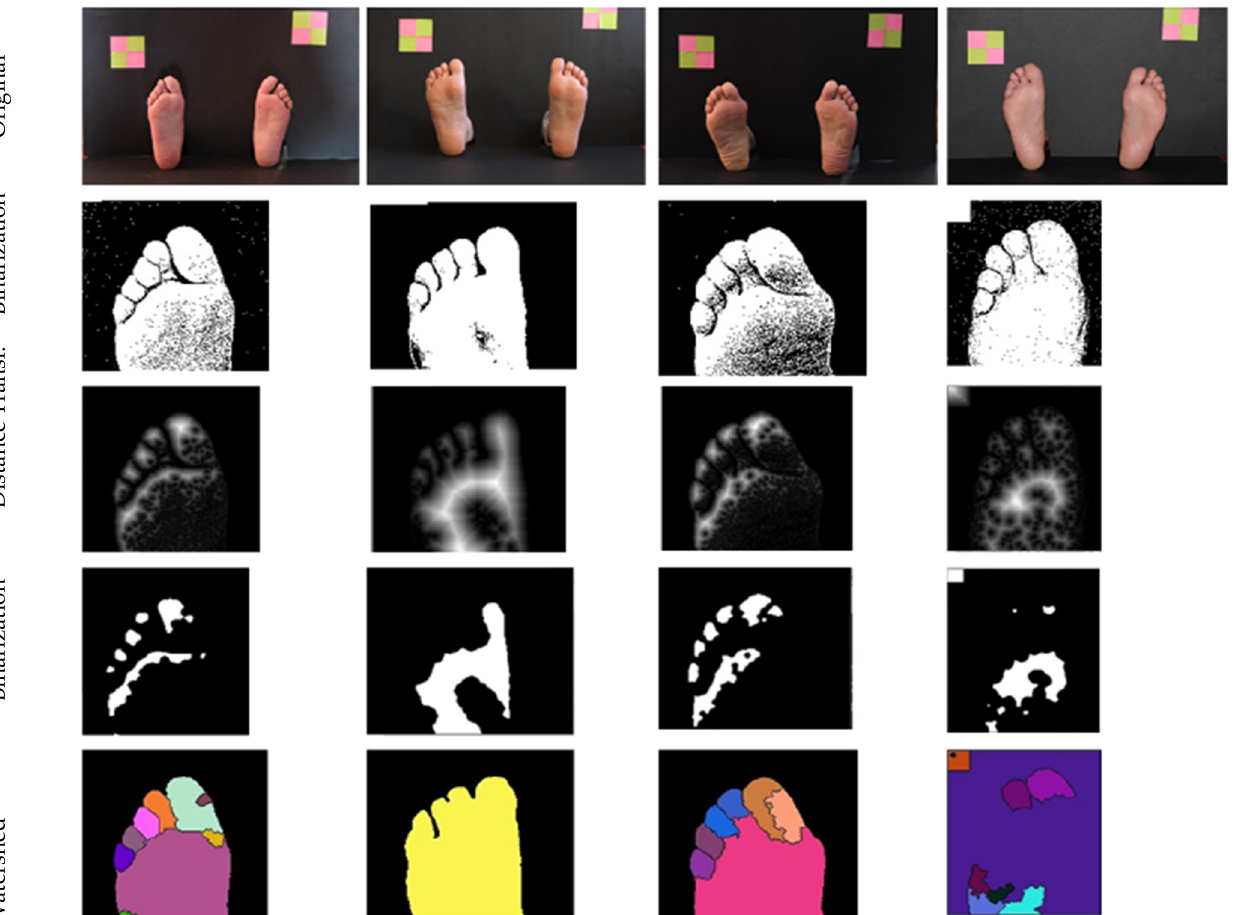
Figure 7. Examples of approaches to toes’ segmentation. (Tested but not used, presented for